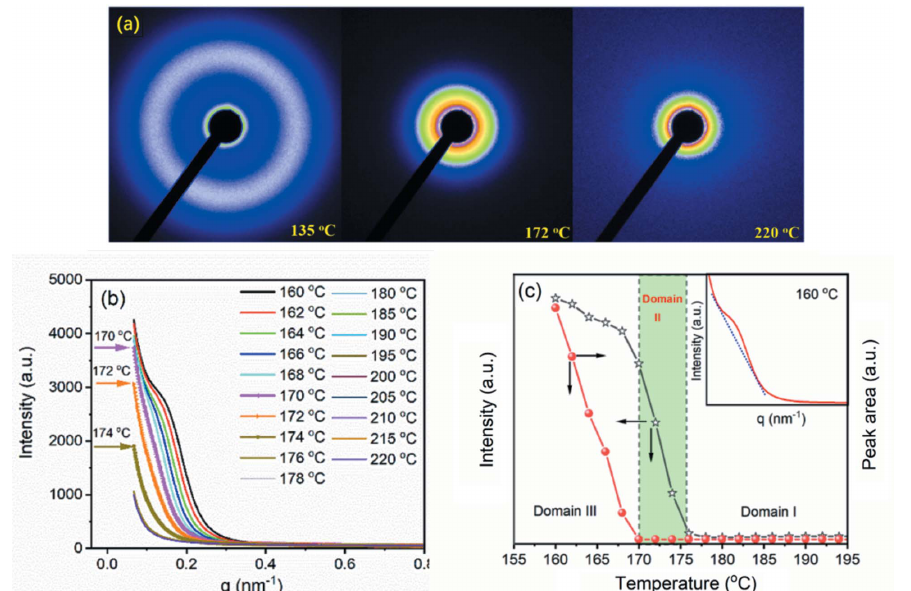
Figure 3 ( a ) Selected 2D SAXS patterns collected during heating. ( b ) One-dimensional SAXS profiles from 160 to 220 (cid:3) C. ( c ) Changes in peak intensity and area at q = 0.14 nm (cid:5) 1 during heating. The inset displays the method to determine peak area. To exclude the influence of scattering intensity on the peak area, a tangent line was drawn below the scattering peak, and only the area between the scattering peak and the tangent line was